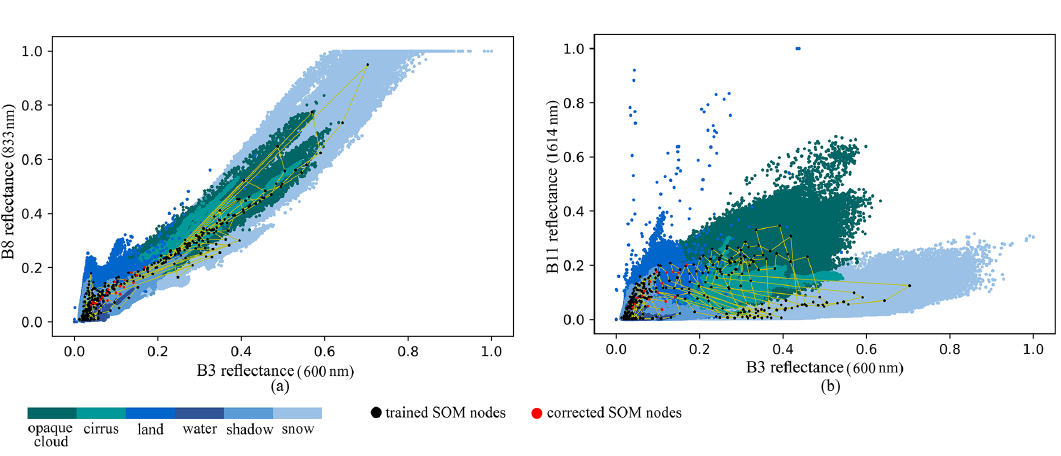
Figure 7. Scatterplots of the six classes of the training